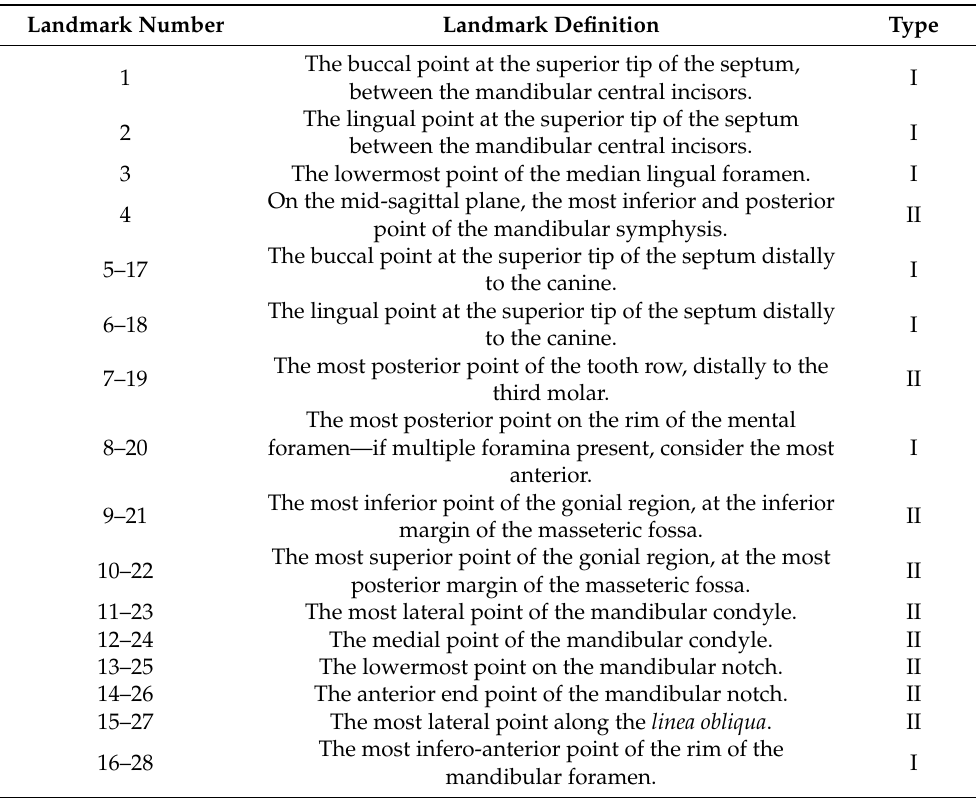
Figure 1. Three-dimensional landmark configuration displayed on the mandible of an individual of Macaca fuscata . The landmark numbers refer to the definitions in Table 1. Table 1. List of landmark definitions used for the analyses of this study. The landmark type (I, II or III) is reported. The landmarks 1–4 are along the midline, the others are both left and